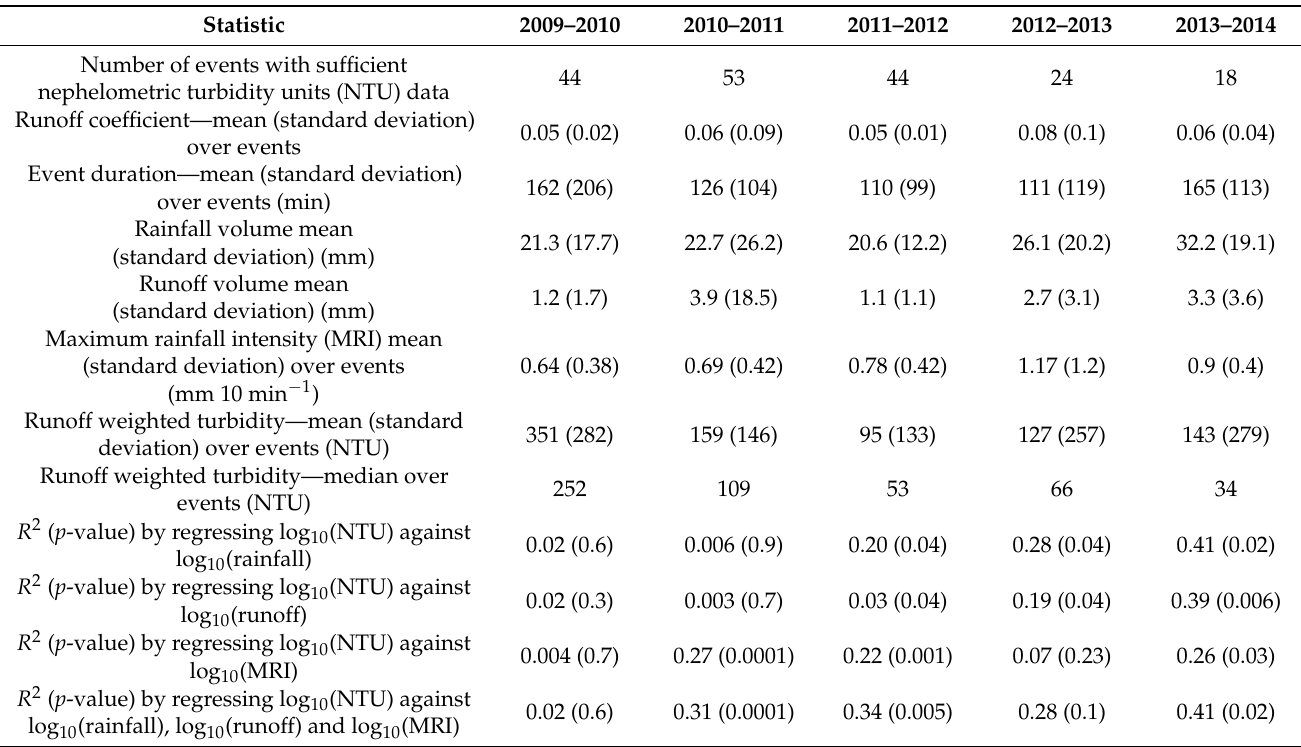
Table 1. Statistical values for the observed 186 rainfall events in the five water years from 2009 to 2014.